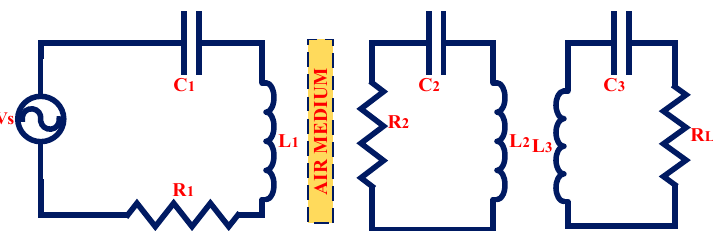
Figure 2. Equivalent circuit of three coil magnetic resonant based wireless power transfer (MRWPT) system.